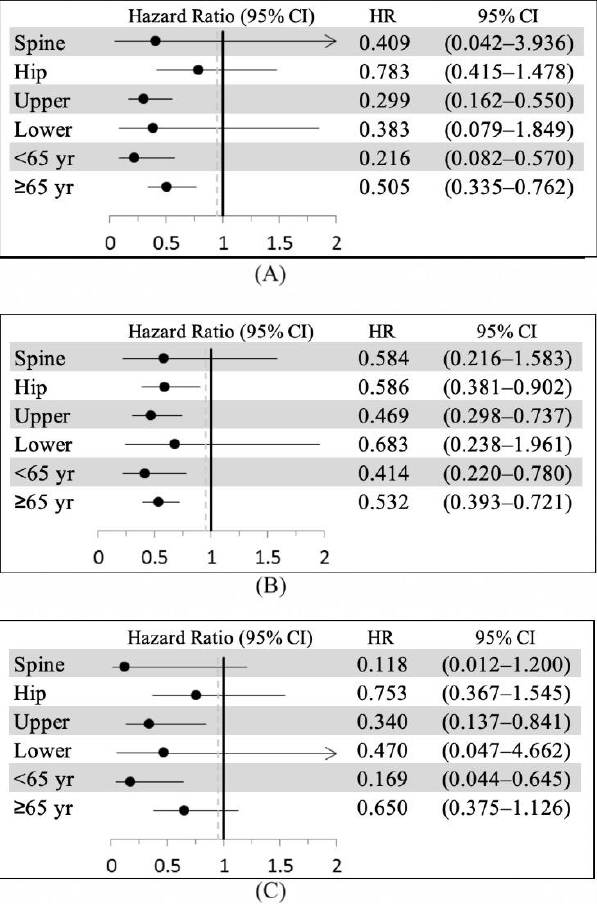
Figure 4. Forest plot of ( A ) second fragility fracture, ( B ) second fragility fracture surgery, and ( C ) revision surgery in patients with bisphosphonate initiation within 3 months after fragility fracture surgery versus more than 3 months after fragility fracture surgery for different fragility fracture types and age groups. SHR, subdistribution hazard ratio; CI, confidence interval; Upper, upper limb; Lower, lower limb.